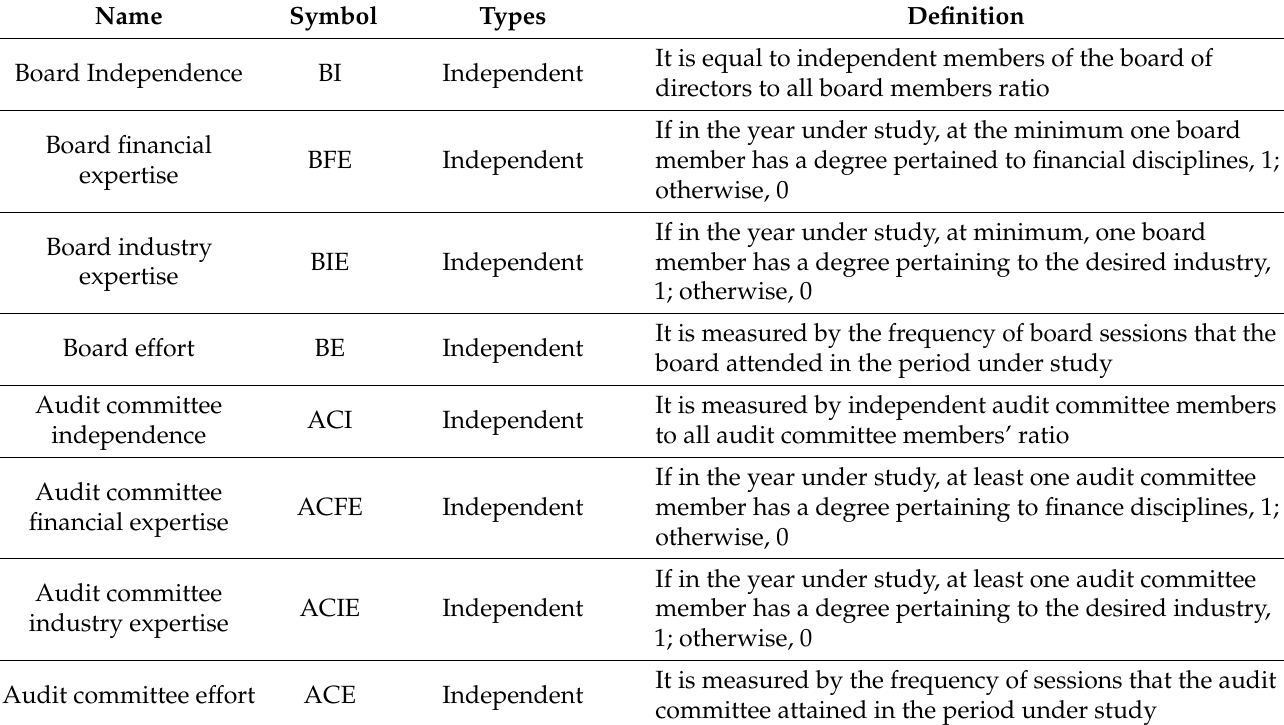
Table 2. The research